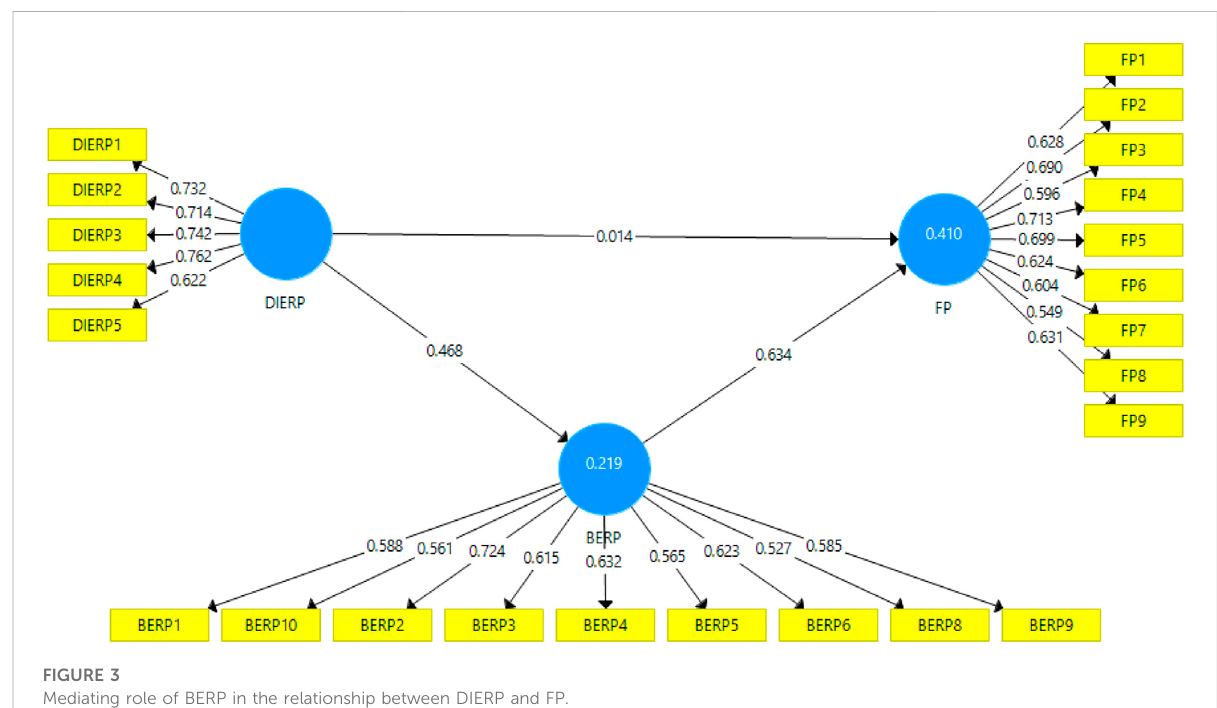
FIGURE 3 Mediating role of BERP in the relationship between DIERP and FP.